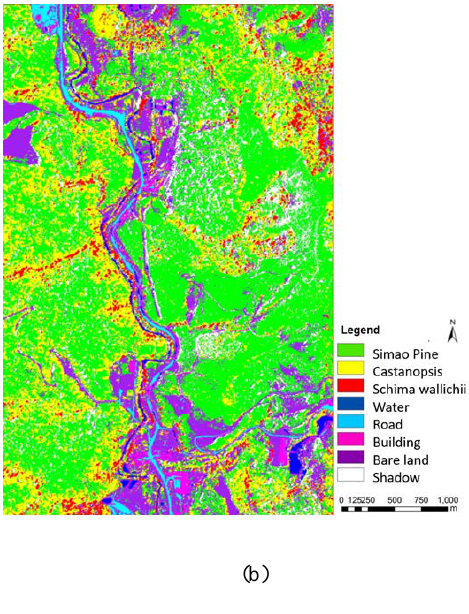
Figure 2. (a) The corrected surface reflectance of airborne hyperspectral data. The central wavelengths of displayed hyperspectral image for red, green and blue bands are 849.30, 694.91 and 543.72 nm. (b) Tree Species Classification using hyperspectral and airborne lidar data.